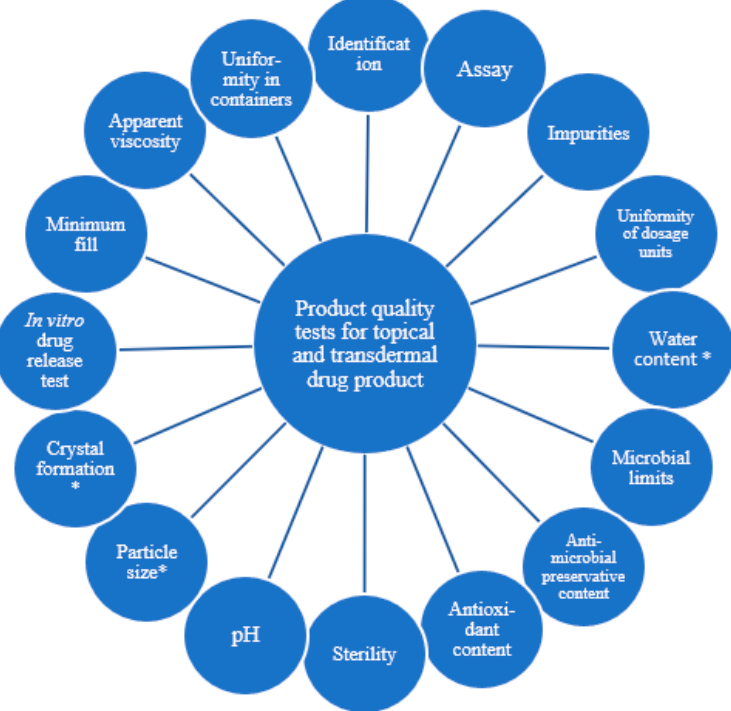
Figure 1. Product quality tests for topical and transdermal drug products. * This test is generally formulation dependent.